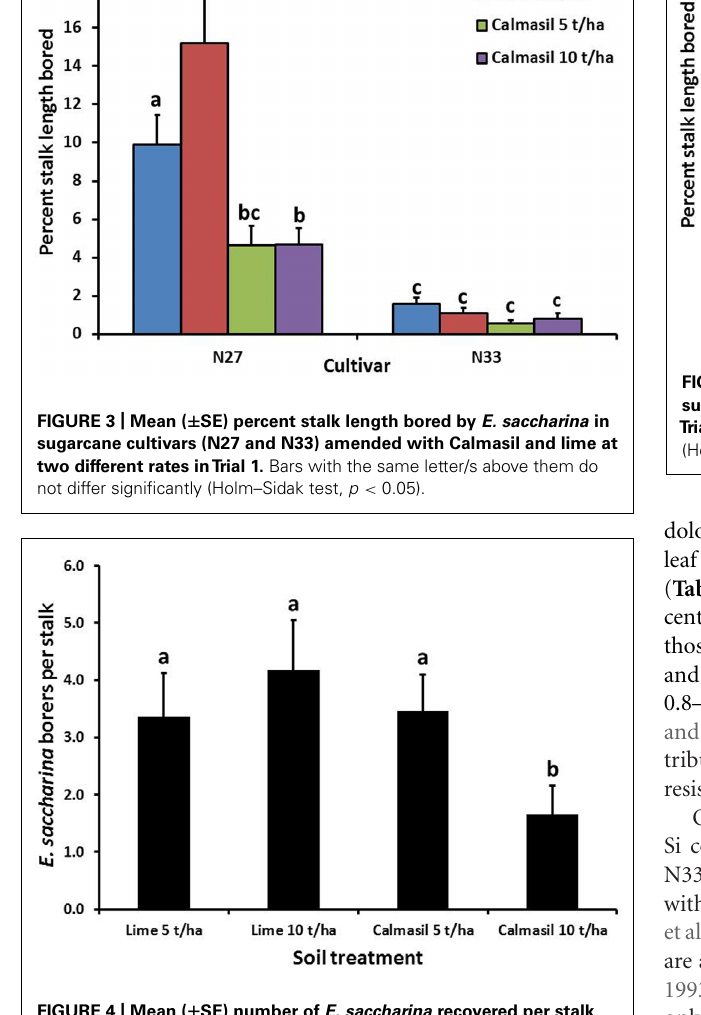
FIGURE 4 | Mean ( ± SE) number of E. saccharina recovered per stalk from sugarcane amended with Calmasil and lime at two different rates inTrial 2. Bars with the same letter/s above them do not differ significantly (Holm–Sidak test, p < 0.05).